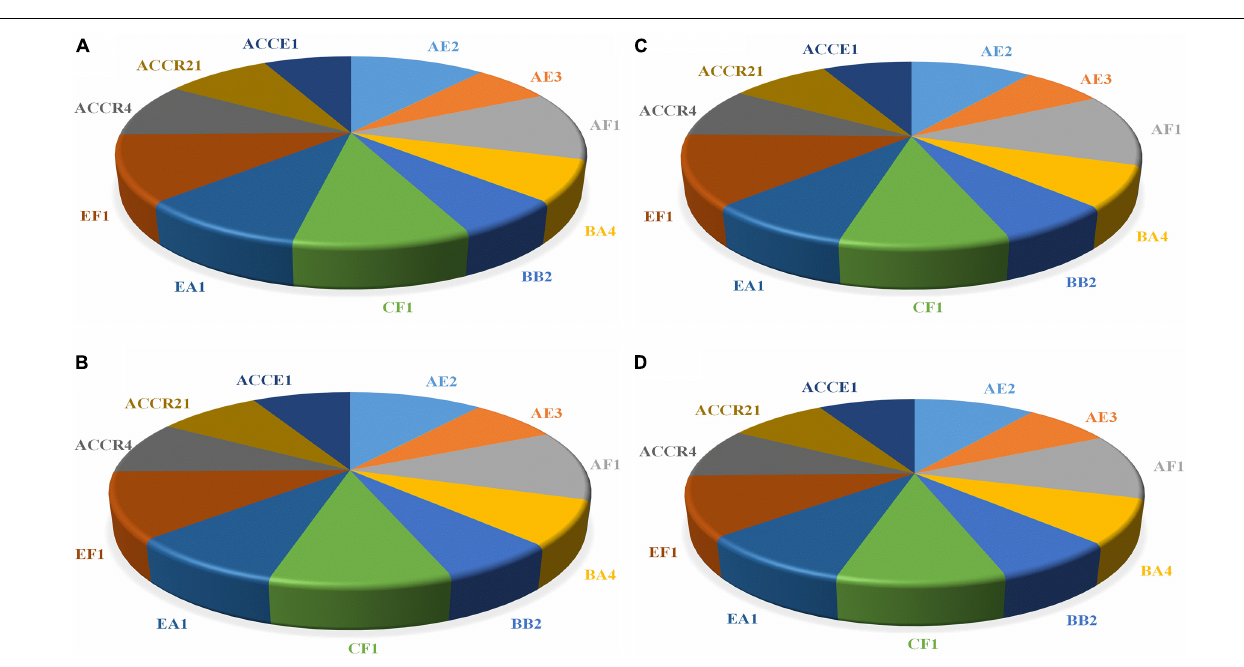
the production of siderophores, phosphate, HCN, and ammonia ( Tables 1, 2 and Supplementary Figure 2